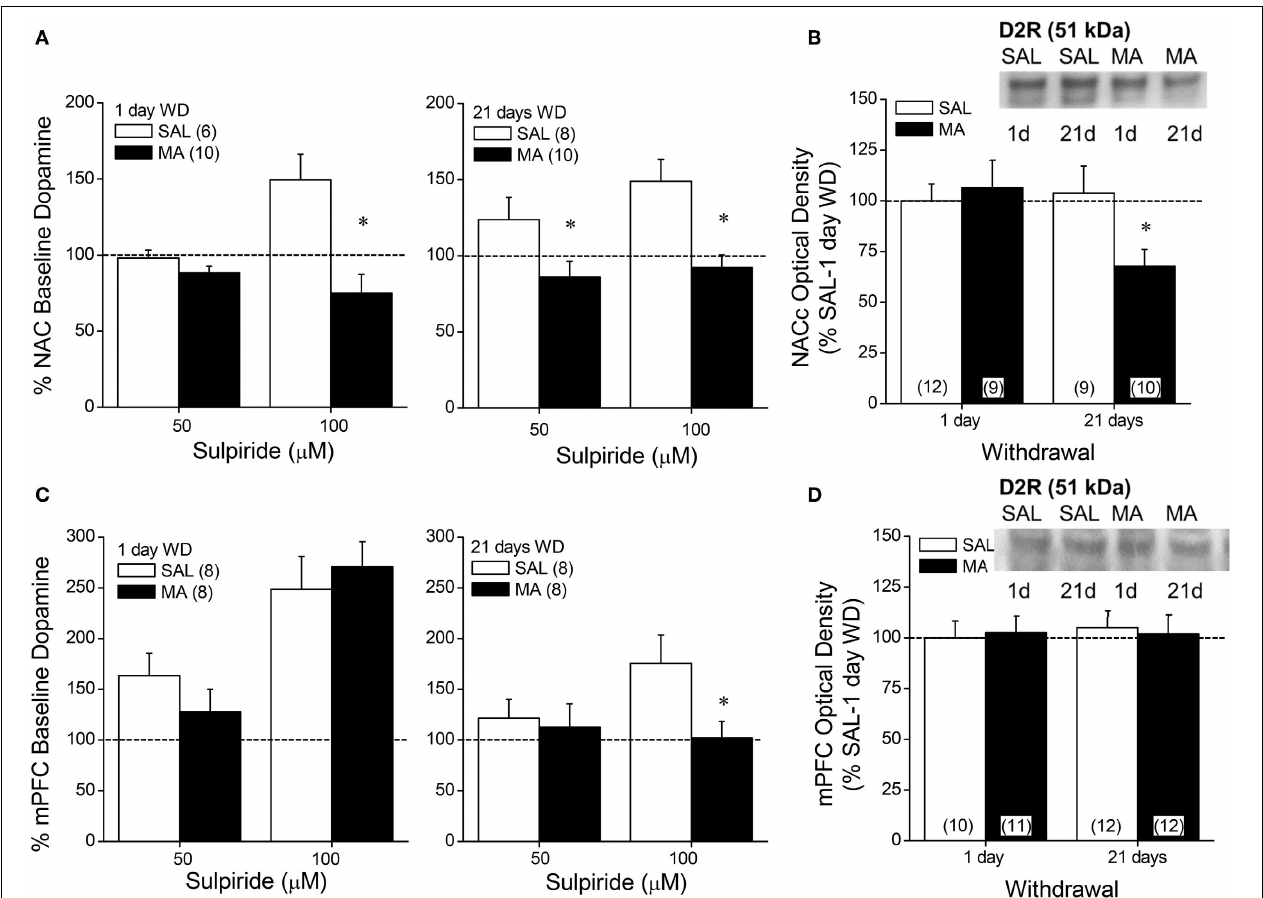
FIGURE 4 | Summary of the effects of a 10-day history of repeated methamphetamine (MA; 2mg/kg) or saline (SAL) upon the capacity of theD2/D3receptorantagonistsulpiridetoelevateextracellulardopamine (A,C) and upon total D2 receptor protein expression (B,D) within the NAC